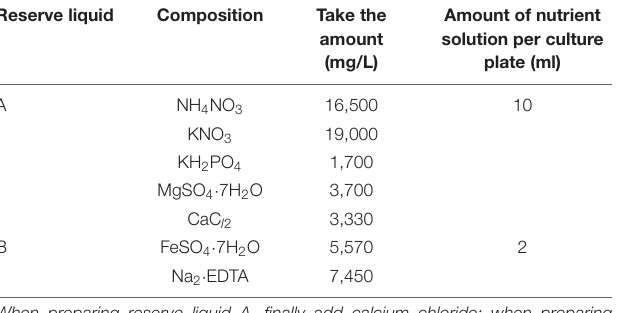
TABLE 4 | Preparation of nutrient solution for subculture and proliferation. Reserve liquid